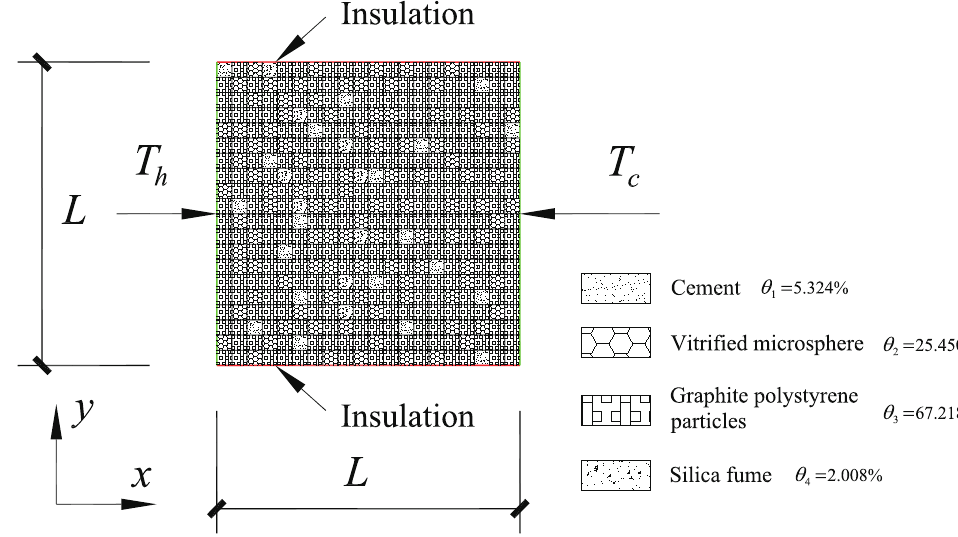
Figure 6. Geometric model of heat conduction unit of the